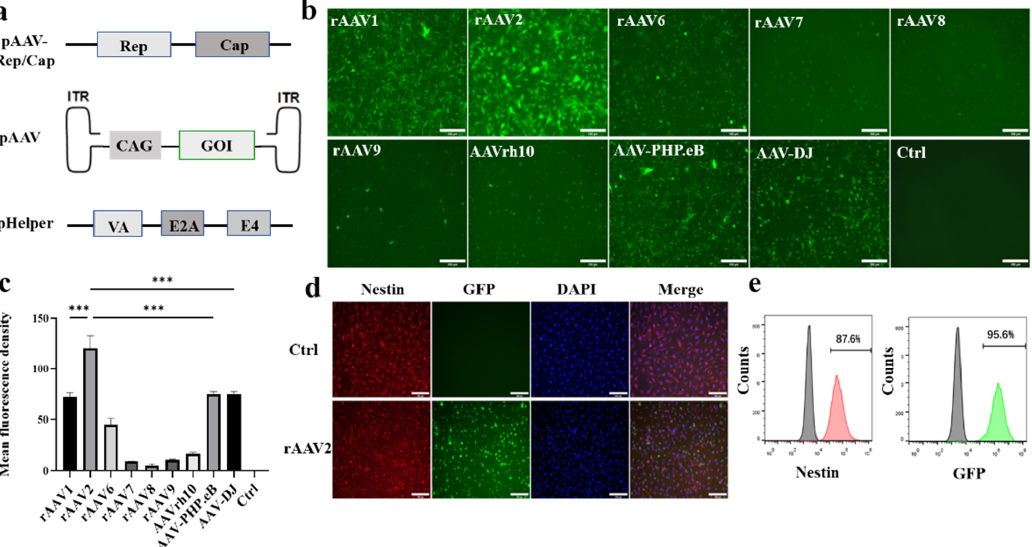
Figure 2. K-NSCs infected with rAAV remain undifferentiated. ( a ): Scheme of the three plasmids used for rAAV production. GOI, gene of interest, i.e., GFP or GALC. ( b ): GFP fluorescence in K-NSCs 48 h after infection with different GFP-encoding rAAVs at an MOI of 10 5 . Scale bar, 100 µ m. ( c ): Mean fluorescence intensity of GFP in transfected K-NSCs quantified with ImageJ software (V1.8.0). Data are expressed as the mean ± SD (n = 5); *** p < 0.001. ( d , e ): The expression of GFP and Nestin in K-NSCs were evaluated 1-week post-infection by immunostaining and flow cytometry, respectively. Scale bar, 100 µ m.